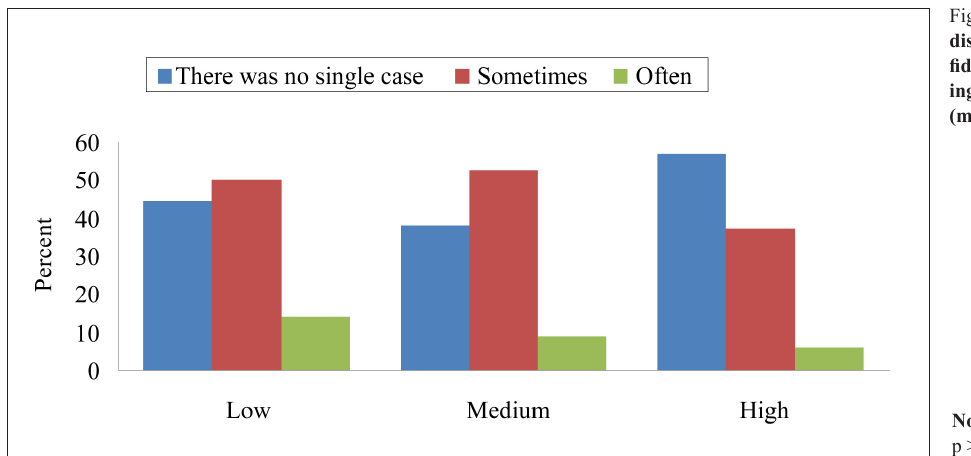
Figure 7. Percentage distribution of self-con- fidence levels by initiat- ing bullying and gender